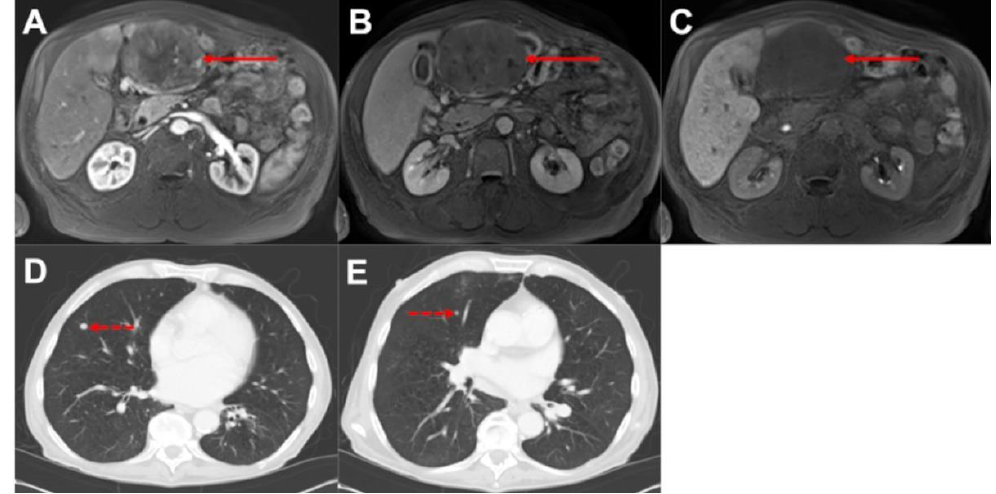
Figure 1. EHD leading to change in management in a patient with solitary HCC. ( A ): liver MRI, arterial phase and axial plane. ( B ): liver MRI, venous/transitional phase and axial plane. ( C ): liver MRI, hepatobiliary phase, and axial plane. ( D ): chest CT, lung window and axial plane. Note the solitary, typical HCC in liver segment VIII (( A – C ), solid arrows) demonstrating arterial hypervas- cularization ( A ), venous/transitional phase washout ( B ), and hypointensity in the hepatobiliary phase (( C ) — note is also made of visually reduced parenchymal contrast uptake due to impaired liver function). Based on hepatic disease, the treatment recommendation of RG1 was curative lo- coregional therapy. However, contrast-enhanced CT ( D ) revealed four pulmonary metastases in the right lung (( D ), dashed arrows). The treatment recommendation was consequently changed to palliative systemic therapy.